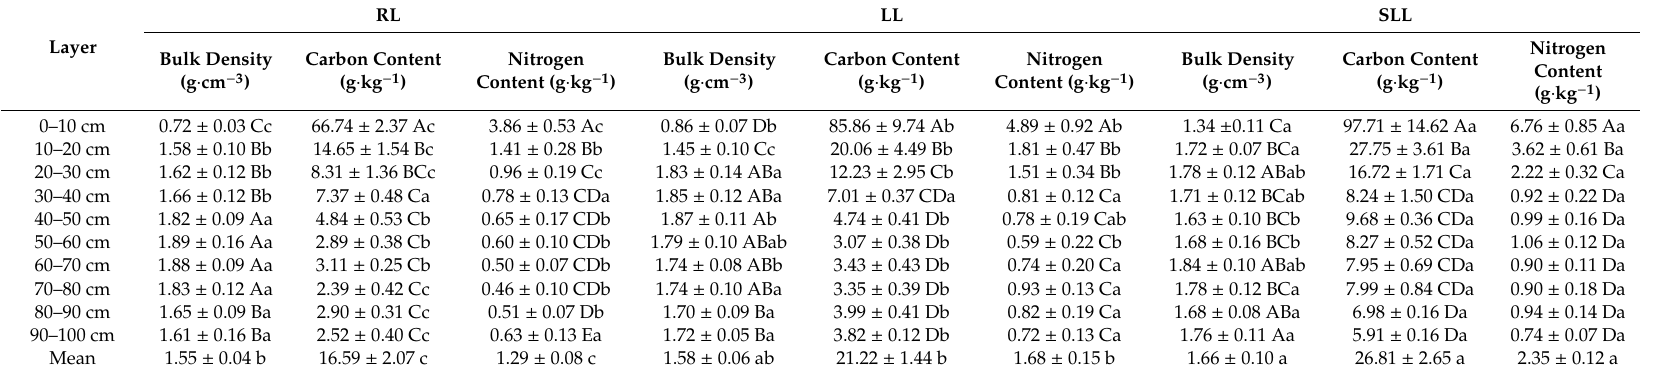
Table A3. Bulk density, carbon and nitrogen contents in soil